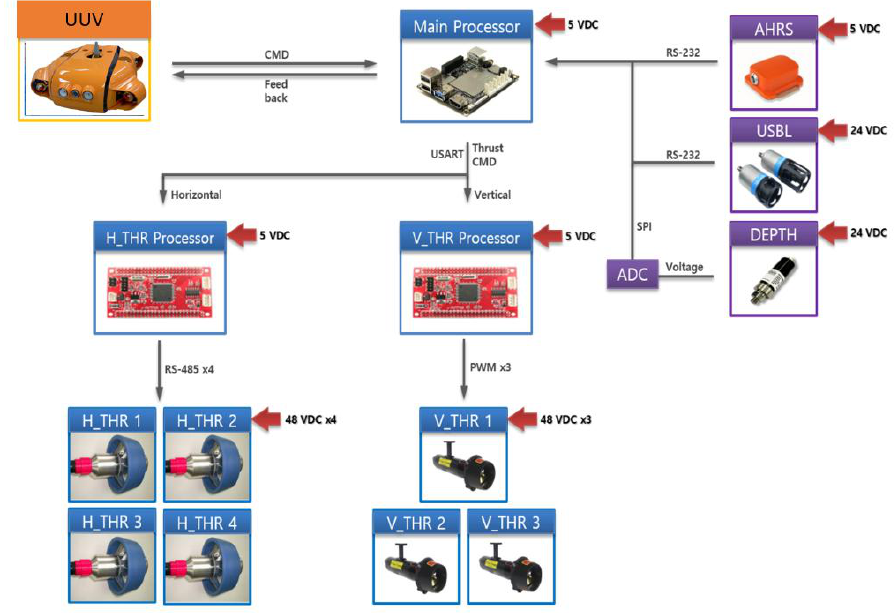
Figure 6. The control structure for the UUV.